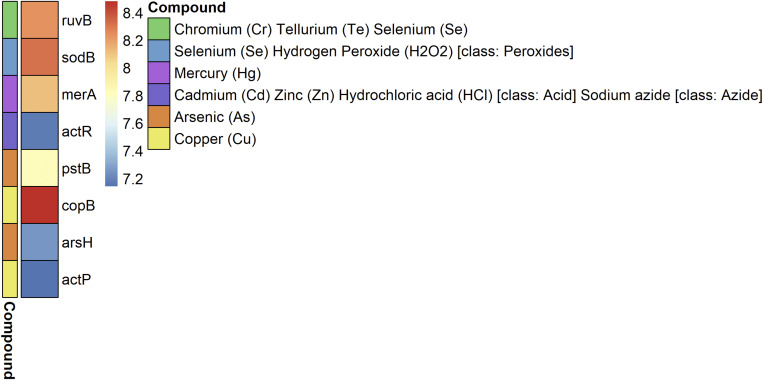
Metal-resistance genes in the plasmidome of Puquio de Campo Naranja. The color scale indicates the abundance of each gene in FPKM (fragments per kilobase per million). Values are plotted on a logarithmic scale. The other colors indicate the metal to which they confer resistance.